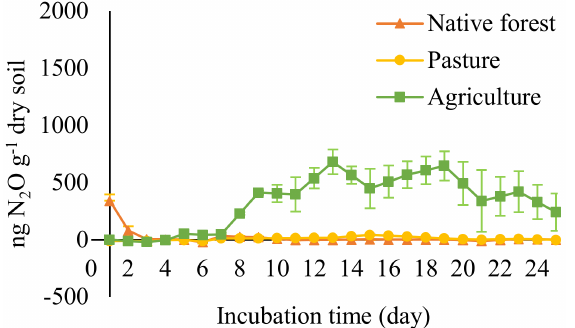
Figure 2. N 2 O fluxes (ng N 2 O g − 1 dry soil day − 1 ) in different land uses in the Brazilian